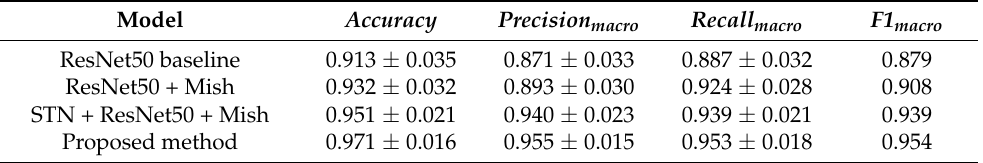
Table 4. Performance comparison of the proposed classification method.